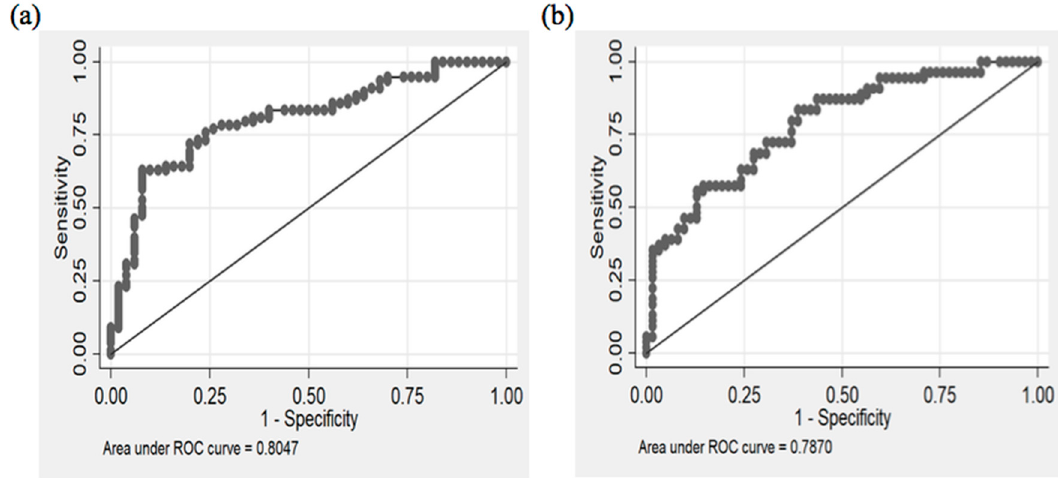
Figure 6. Diagnostic potential of circulating miR-133b and miR-21 through ROC curve: ( a ) Diagnostic potential of miR-133b, AUC = 0.80 (0.73 to 0.88 at 95% CI) with 75.6% sensitivity and 76% specificity; ( b ) Diagnostic potential of miR-21, AUC = 0.79 (0.70–0.87 at 95% CI) with 72.2% sensitivity and 69.4% specificity.